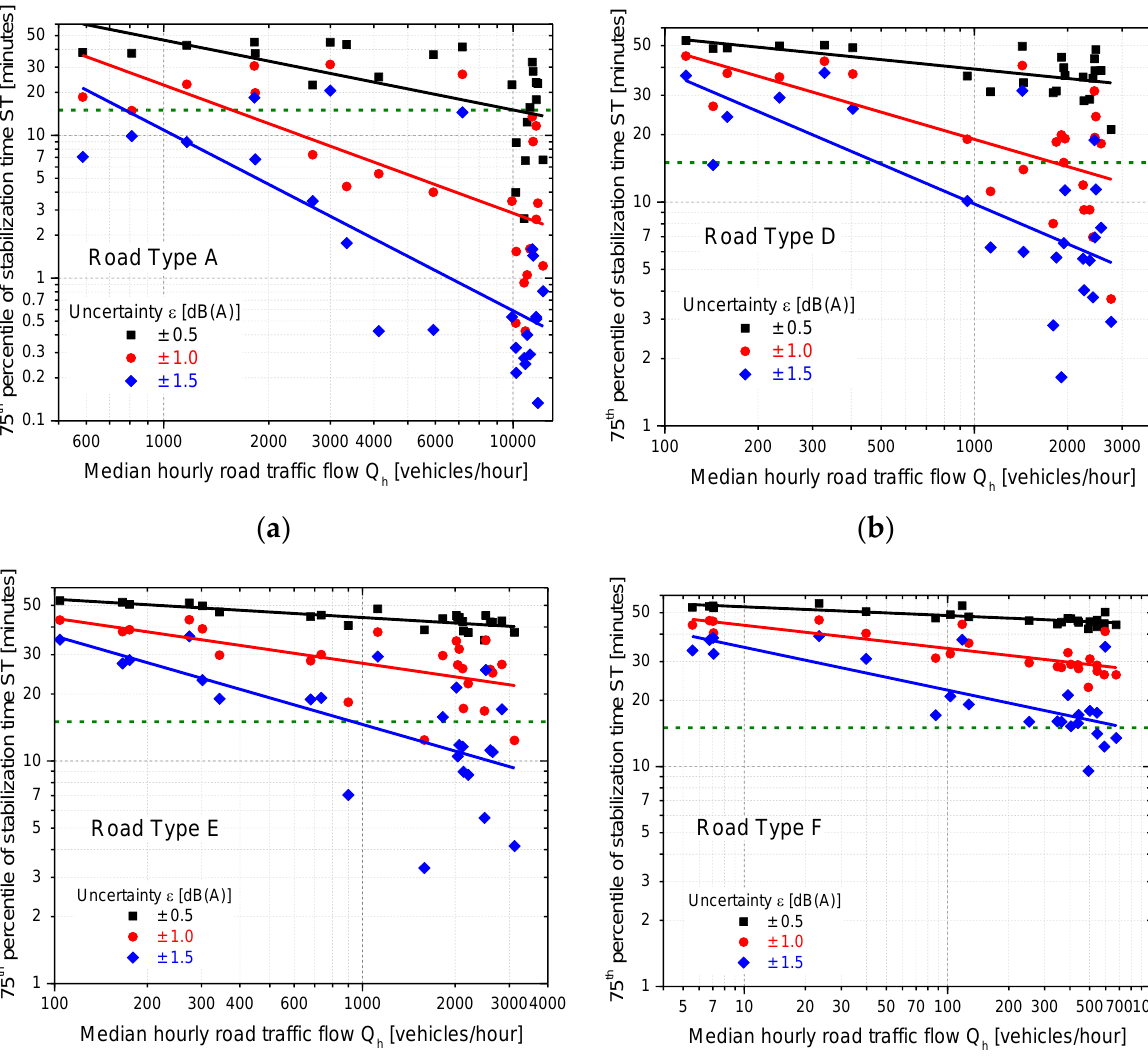
Figure 5. 75th percentile of ST values for the three preset uncertainties ε of the hourly L Aeq,1h estimate, grouped by the four road types (( a – d )-letters refer to road types A, D, E, F) and hour, versus median hourly road traffic flow Q h .